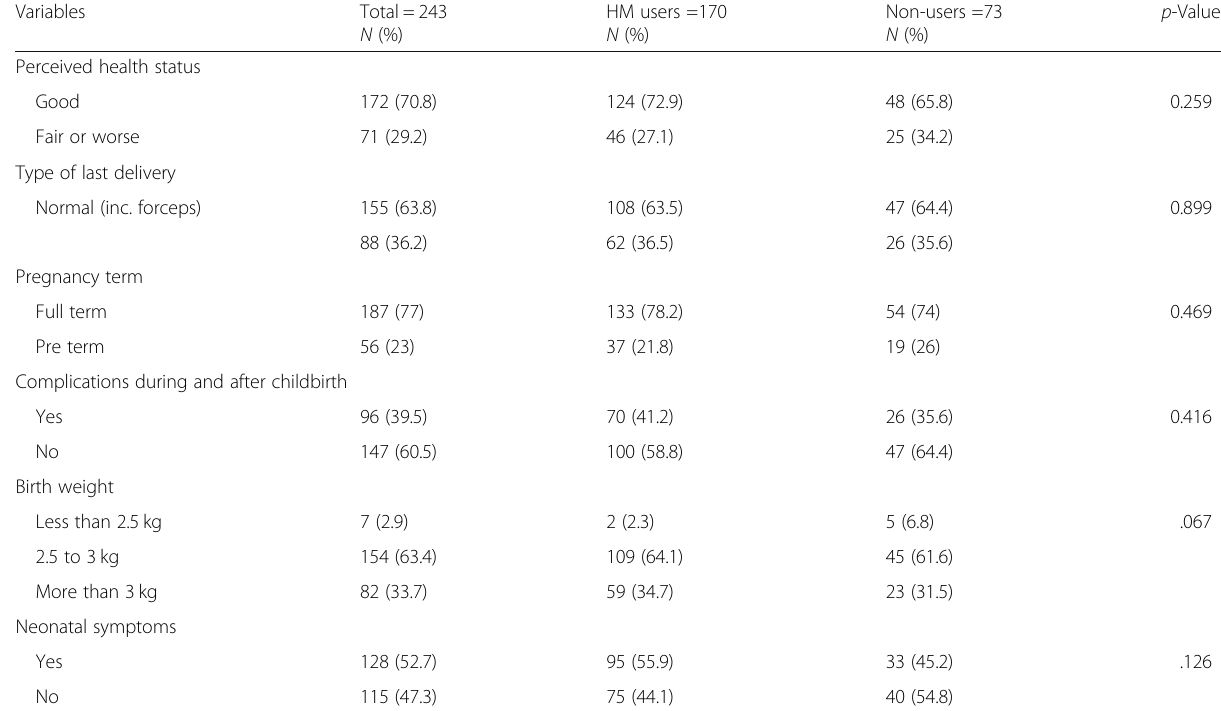
Table 3 Pregnancy outcomes of participants